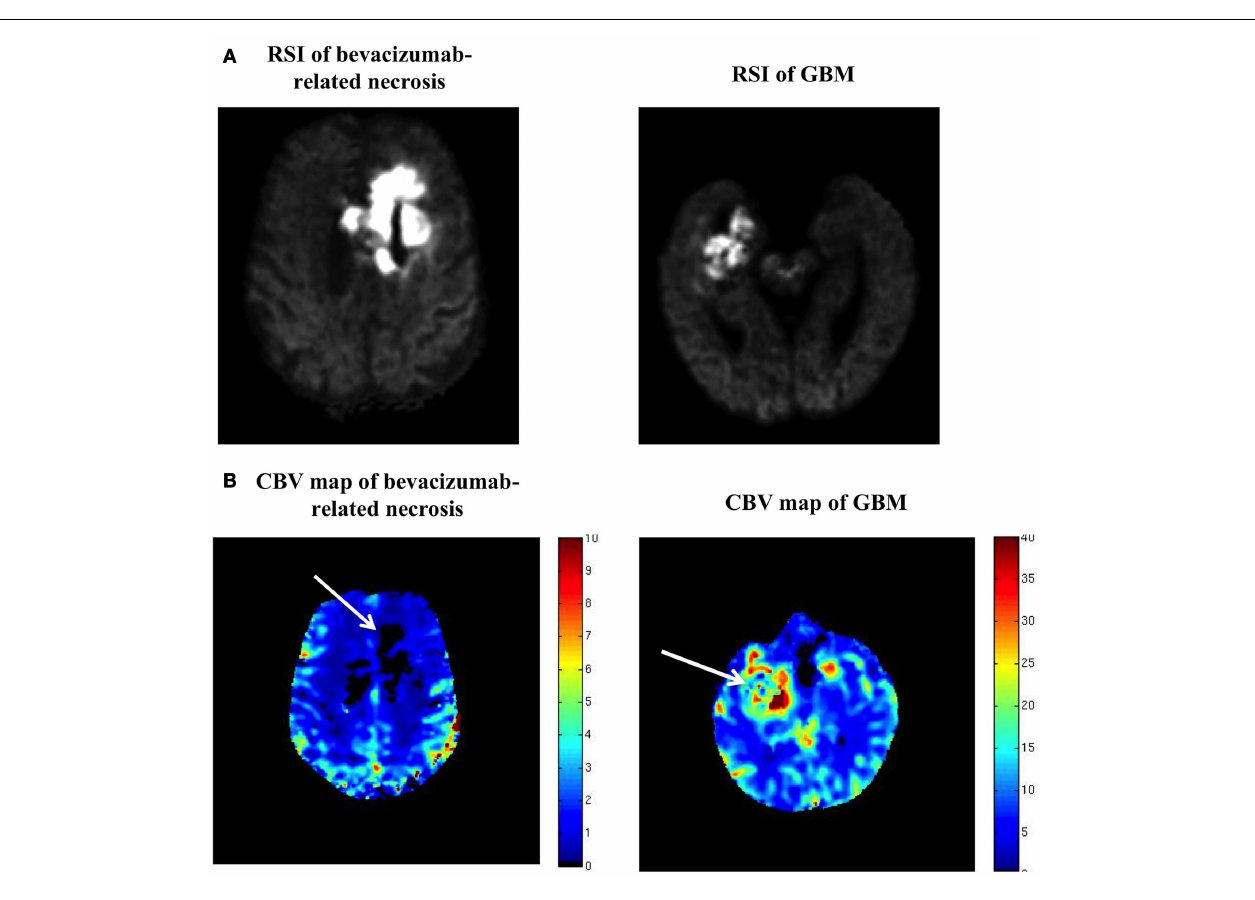
FIGURE 2 | (A,B) RSI and CBV maps in bevacizumab-related necrosis versus GBM. (A) is a side-by-side comparison of the RSI signal seen in our patient and the RSI signal seen in a typical GBM, with the two RSI images scaled